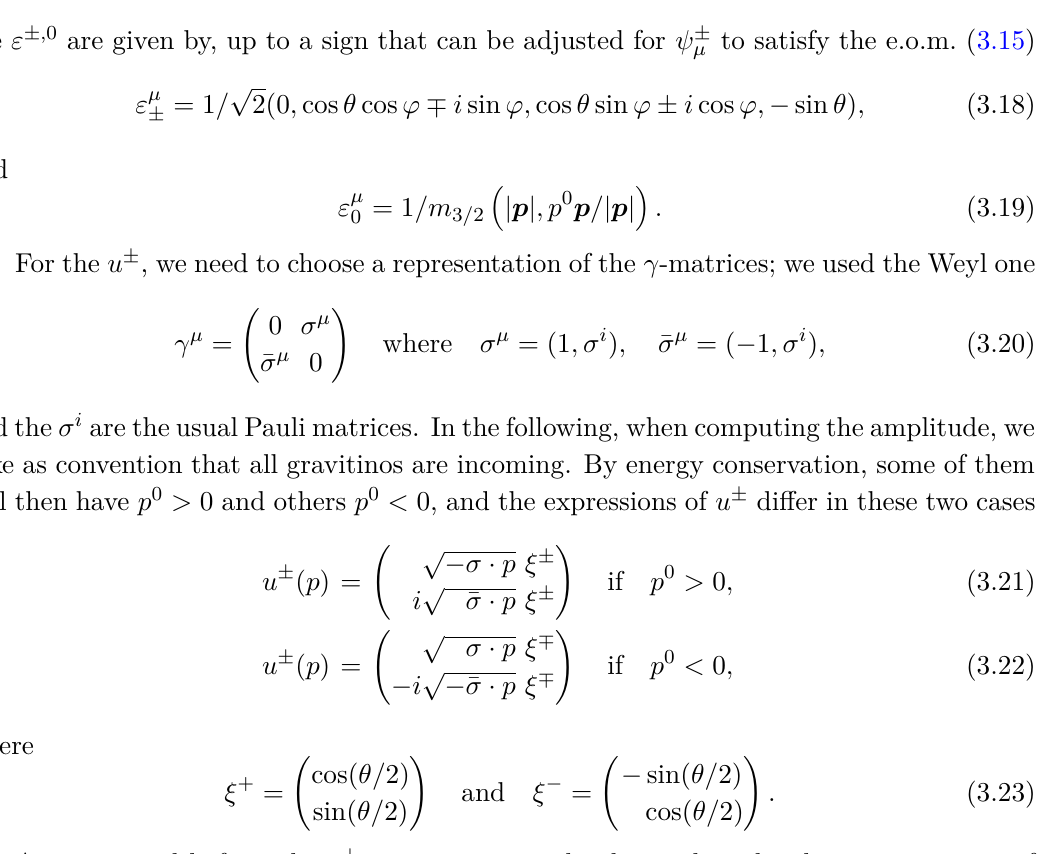
Figure 1 . Conventions for the orientation of the fermionic lines in the s, t, u